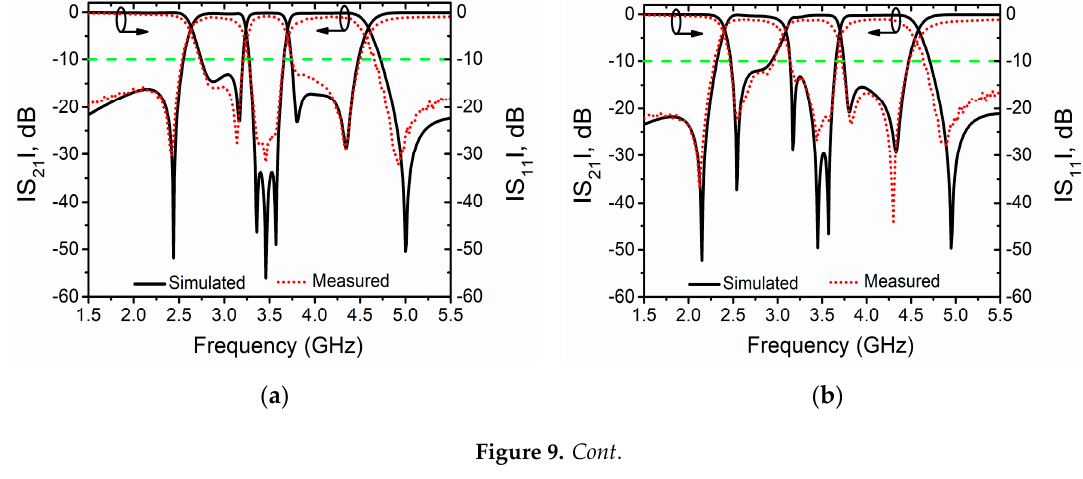
= 100 pF, C = 2.4 pF, C = 100 pF). F S T